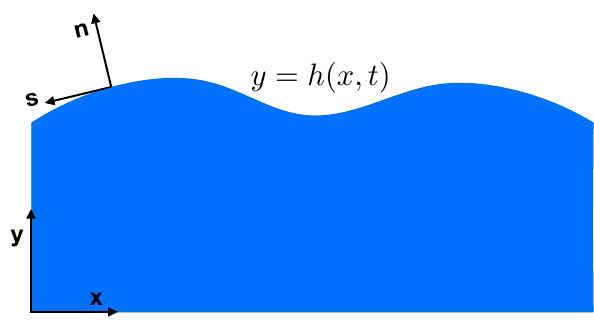
Figure 1: Fluid domain with free surface y = h ( x , t